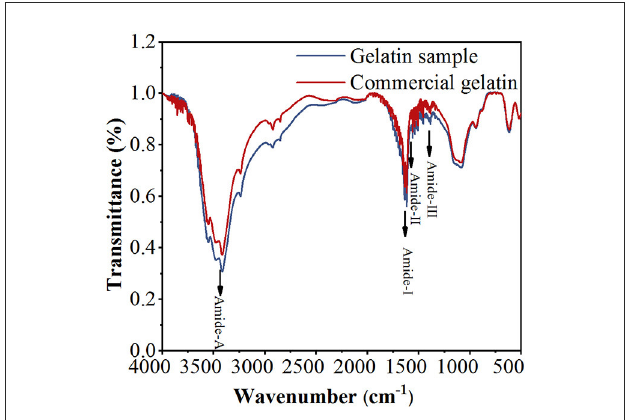
FIGURE3 Fourier transform infrared (FTIR) spectra of the gelatin sample (GS) and commercial gelatin (CG).